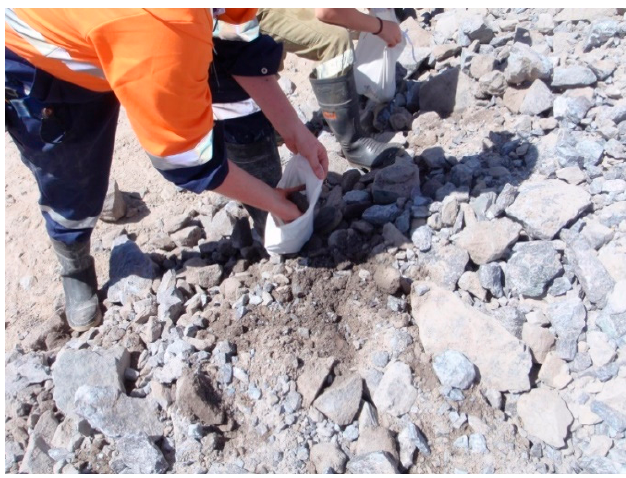
Figure 6. Grab sampling from a surface stockpile showing the challenges of collecting a representative sample and oversampling fine material.